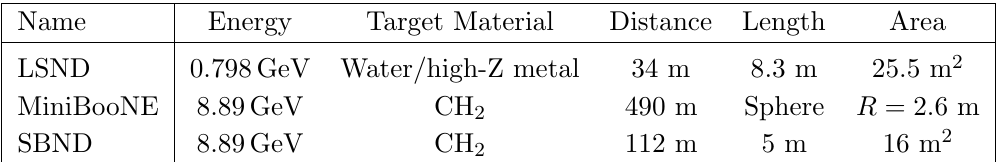
Table 2. Summary of the relevant characteristics of the experiments considered. Detector distances are taken from the beam target to the center of the detector. LSND has a cylindrical geometry, MiniBooNE a spherical one and SBND should have a square intersection with the beam axis.